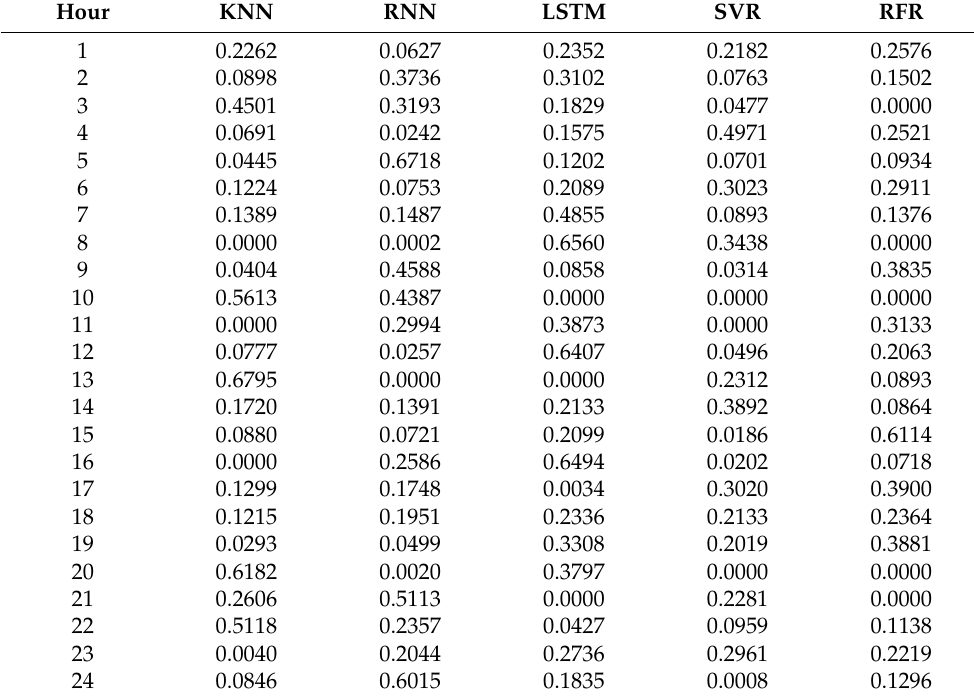
Table 8. The respective weights for each individual model using a WOA for 24